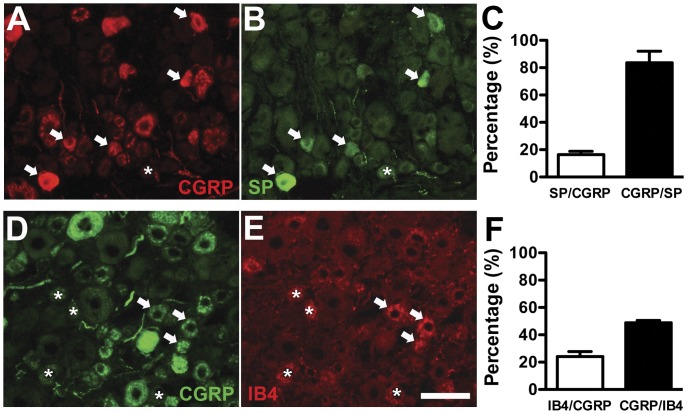
Colocalization of substance P (SP) and isolectin B4-binding (IB4) neurons with calcitonin gene-related peptide (CGRP) neurons in dorsal root ganglion (DRG).(A, B) Double-labeling immunofluorescent staining was performed with anti-CGRP (A in red) and anti-SP (B, in green) antisera on DRG sections. Some of CGRP(+) neurons were colocalized with SP(+) neurons (arrow in A and B), whereas there were CGRP(−)/SP(+) neurons (asterisk in A and B). (C) The graph shows the colocalization ratios of SP(+)/CGRP(+) (open bar, n = 5) and CGRP(+)/SP(+) neurons (filled bar, n = 5). (D, E) These graphs show the coexpression of CGRP(+) (D in green) and IB4(+) (E in red) neurons on DRG sections. There was limited colocalization of IB4(+)/CGRP(+) neurons (arrow in D, E), and there was CGRP(−)/IB4(+) neurons (asterisk in D, E). (F) The graph shows the colocalization ratio of IB4(+)/CGRP(+) (open bar, n = 5) and CGRP(+)/IB4(+) neurons (filled bar, n = 5). Bar, 50 µm.